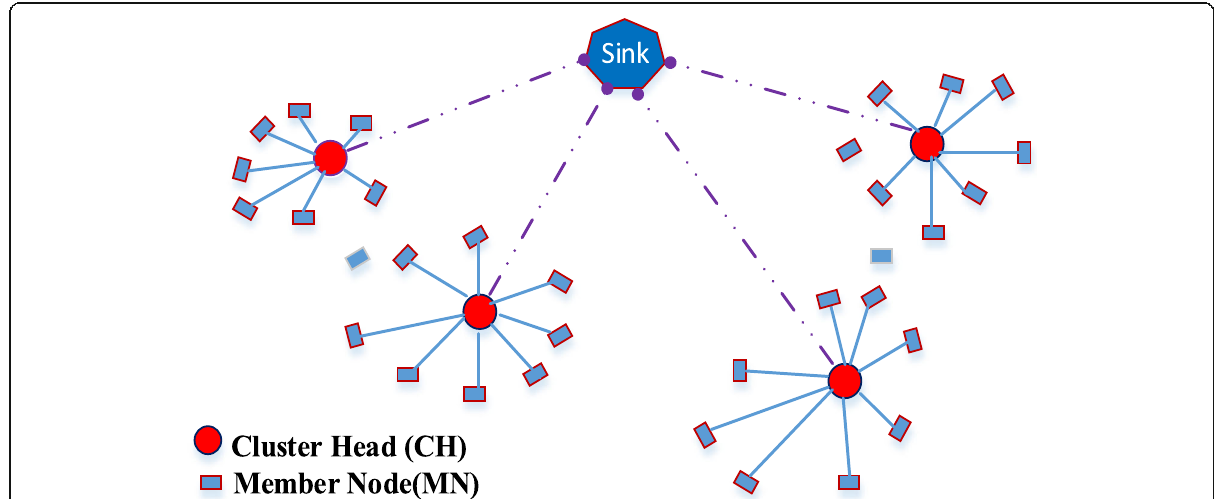
Fig. 1 A clustering scheme of a wireless sensor network. The clustering in WSN composes Node members (NM) and Cluster head (CH). CH is selected from among NM. The functions of CHs are not only to collect the information from the NM but also to aggregate captured data that forwarded to the BS. Clustering provides various advantages like energy efficiency, prolonging lifetime, scalability, and less delay. However, the clustered WSNs also have got the drawback such as the aggregated data fault problem at CHs that caused the network reliability of the monitoring, and predicting applications